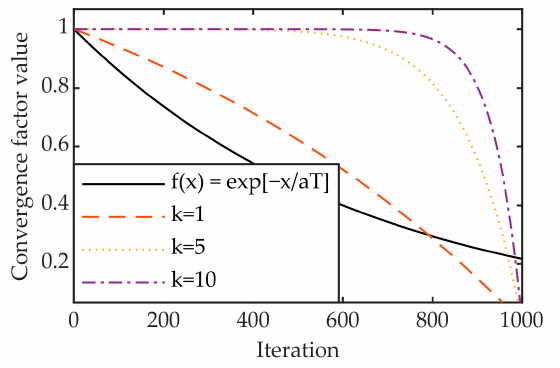
Figure 3. Convergence factor comparison chart.